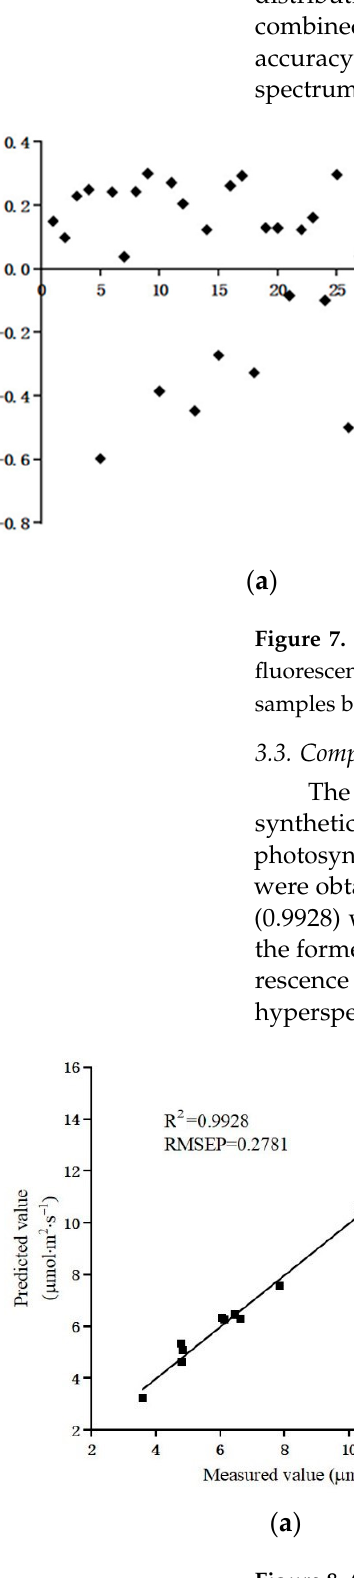
spectral model l; ( b ) scatter plot of measured and predicted photosynthetic rates based on hyperspectral